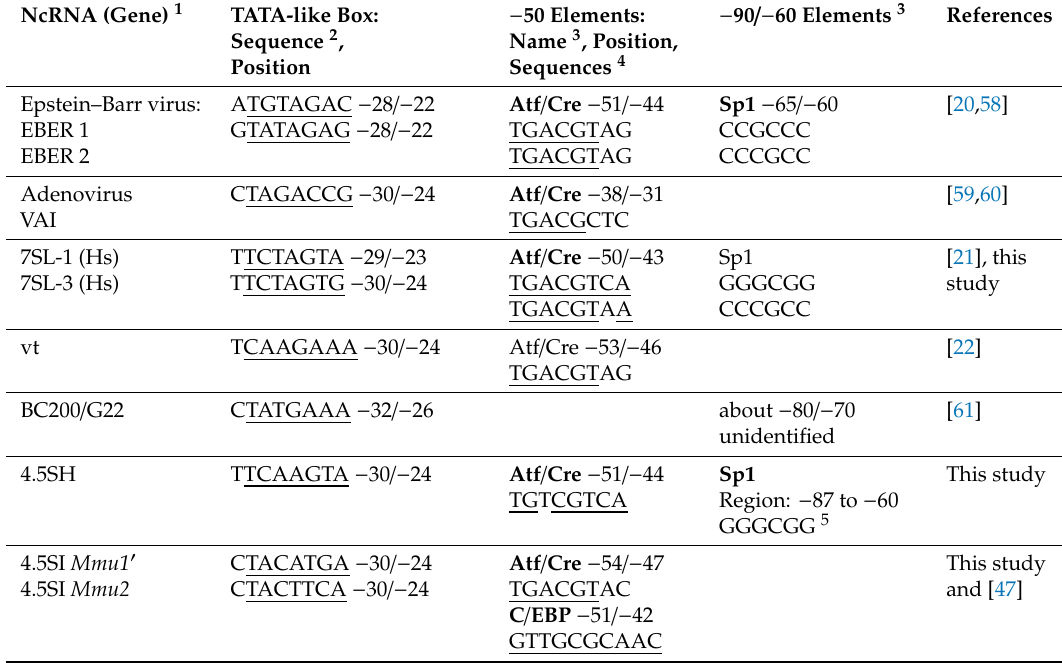
Table 1. The potential regulatory elements in 5 (cid:48) -flanking sequences of genes transcribed by pol III from type 2